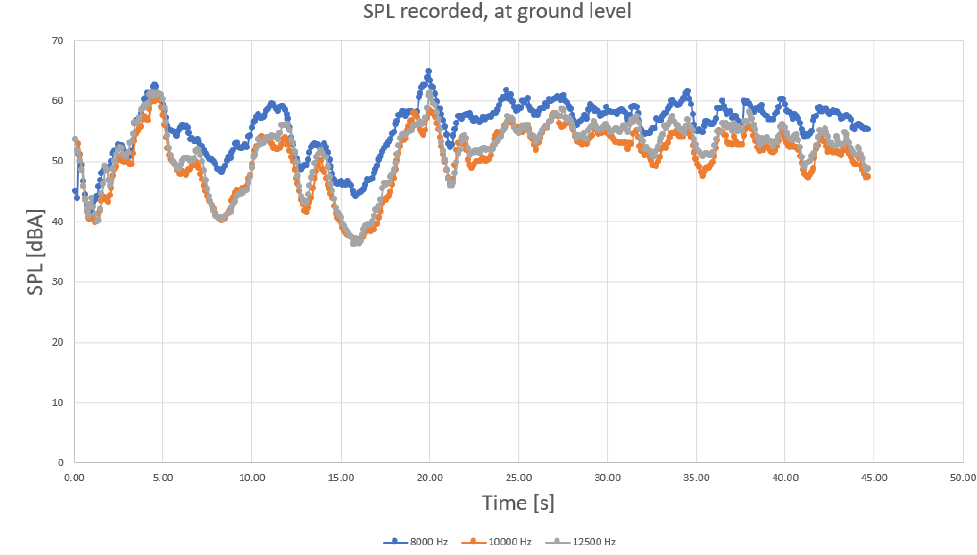
Figure 6. SPL recorded for higher frequency range, ground level (at 8 kHz, 10 kHz and 12.5 kHz, with blue—8 kHz, orange—10 kHz, and grey—12.5 kHz